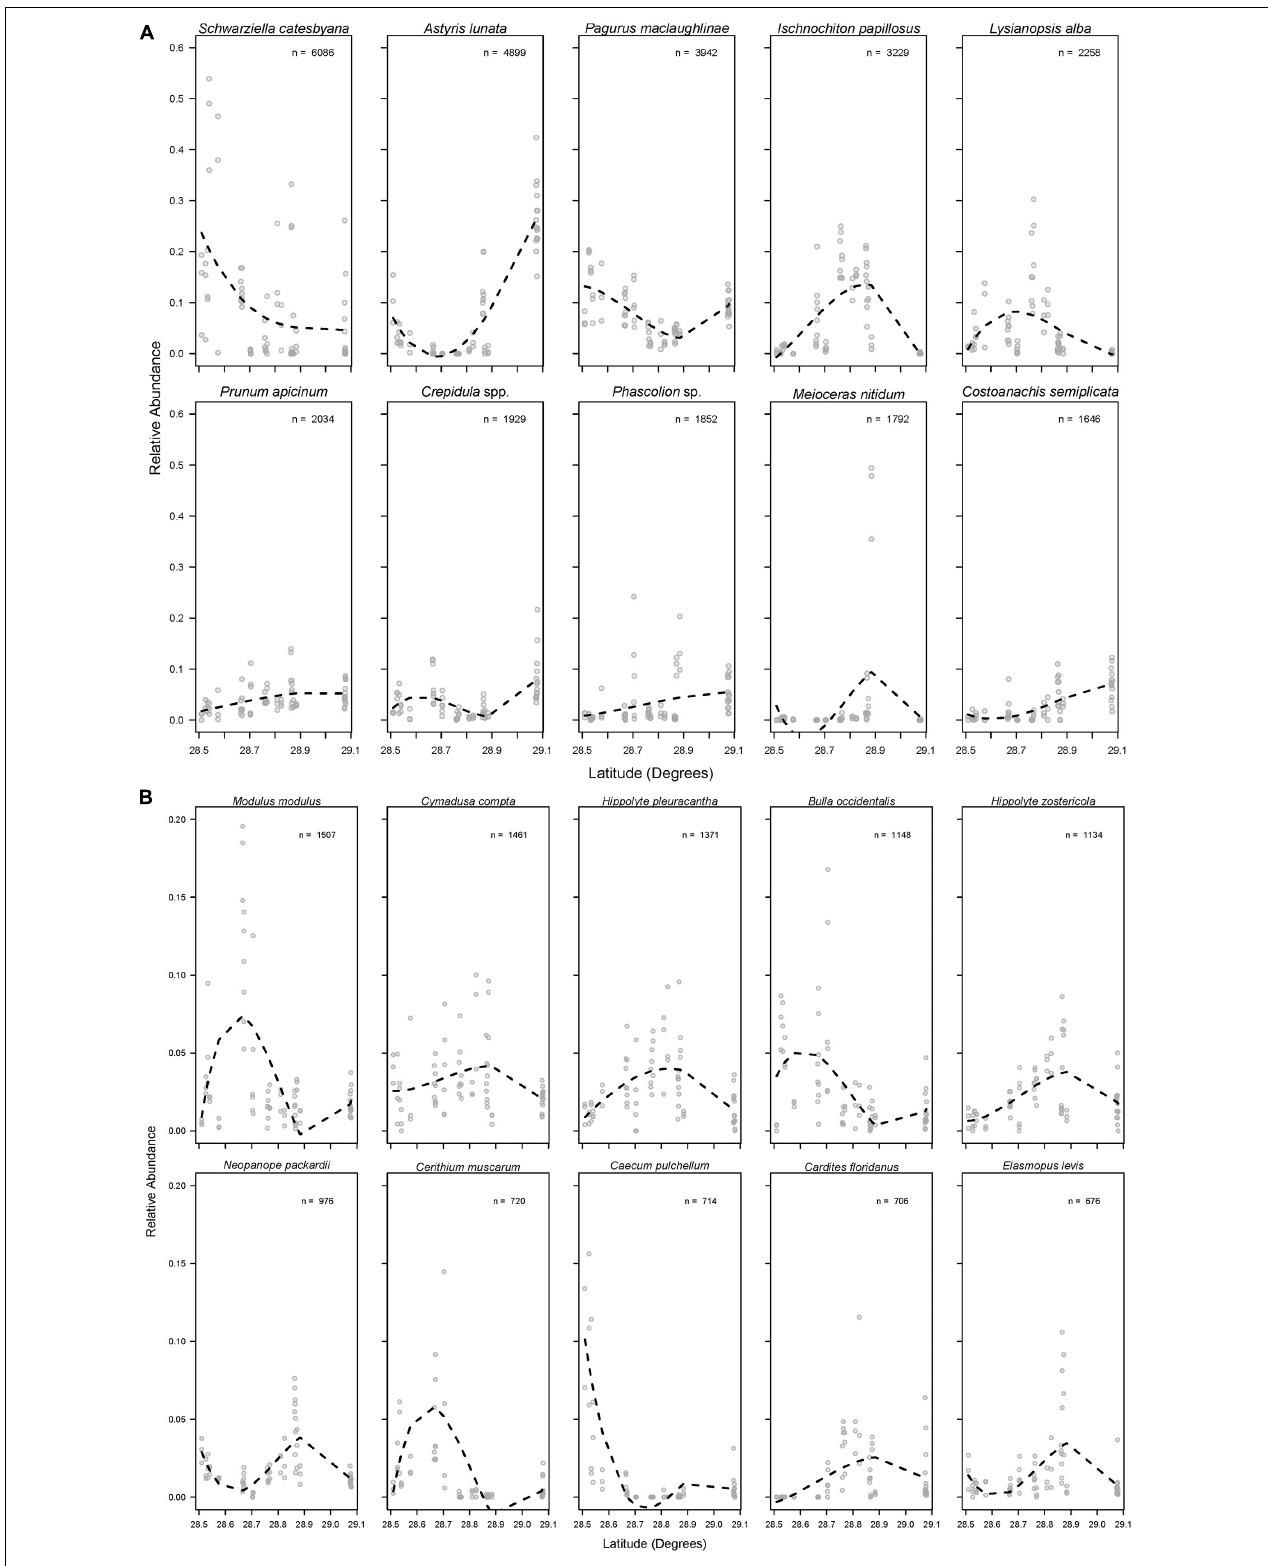
FIGURE 7 | Relative abundances of the (A) 1st–10th and (B) 11th–20th most abundant species across latitude. Dashed lines represent the moving average of relative abundance across latitude. Note the different y -axis scales in each panel, “ n ” = the total number of each species found across all samples.